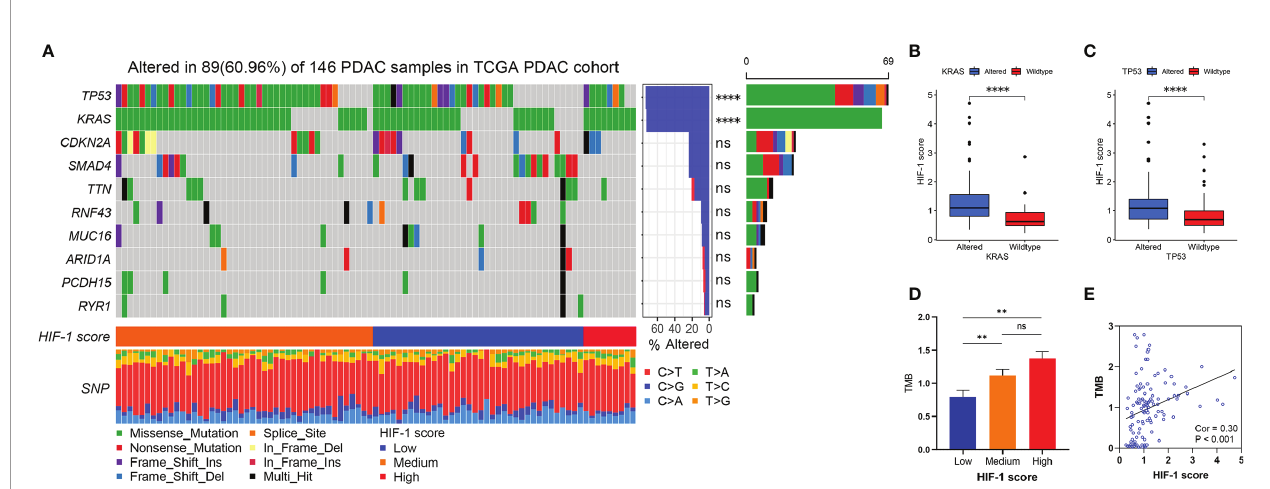
FIGURE 5 | Association between HIF-1 score and genomic alteration in PDAC. (A) The waterfall plot shows the top 10 most commonly mutated genes in patients with PDAC. HIF-1 score was signi fi cantly correlated with KRAS and TP53 mutation. (B) Higher HIF-1 score was found in KRAS altered PDAC. (C) Higher HIF-1 score was found in TP53 altered PDAC. (D) TMB in low HIF-1 score group PDAC was much lower than those in medium and high HIF-1 score group PDAC. (E) HIF-1 score was positively associated with TMB in PDAC. PDAC, pancreatic ductal adenocarcinoma; TMB, tumor mutation burden. ns > 0.05; **P value < 0.01; ****P value <